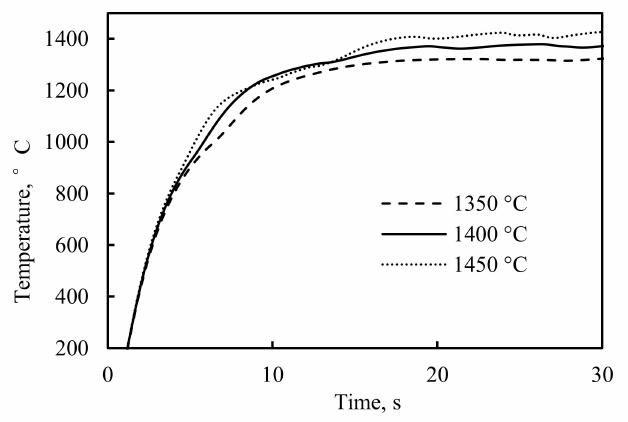
Figure 12. The temperature increase of the bar at monitor point 2 for di ff erent melting